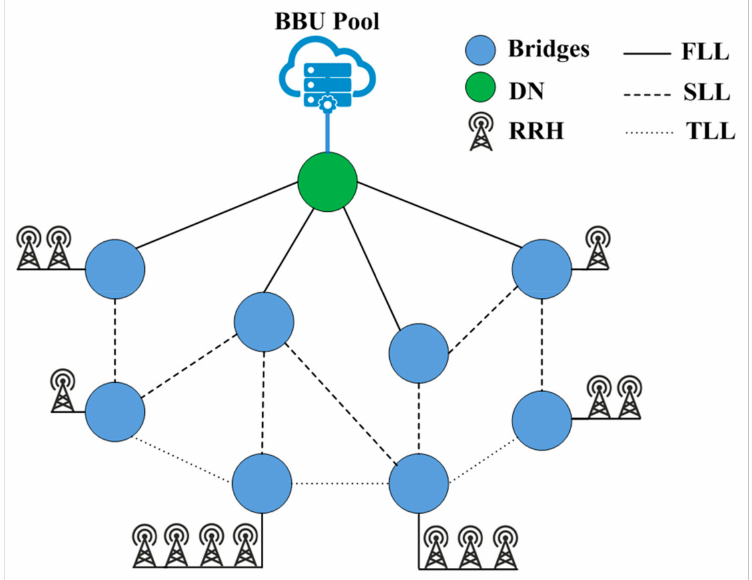
Figure 2. Proposed Ethernet-based fronthaul bridged